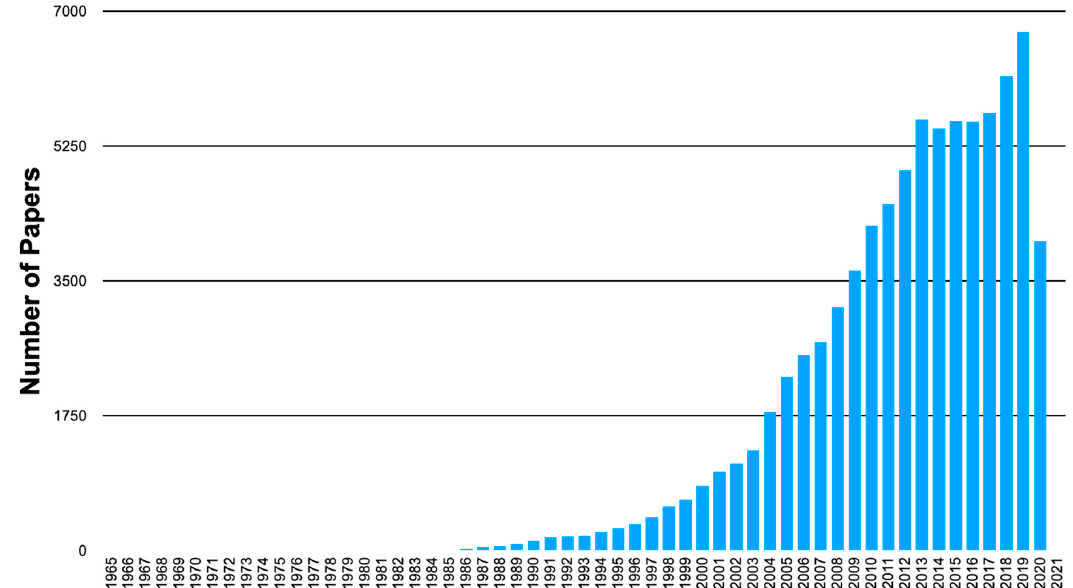
Figure 1. The number of published papers mentioning “biosensors” derived from statistics provided by the Web of Science. The search was performed for the keyword “biosensors” in the topic. (The statistics for 2020 was not complete).